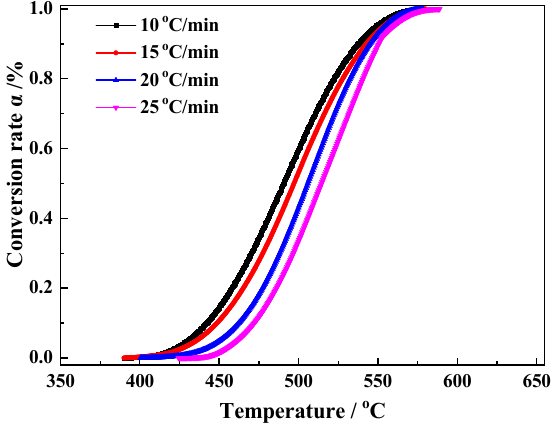
Figure 8. Conversion rate graph.